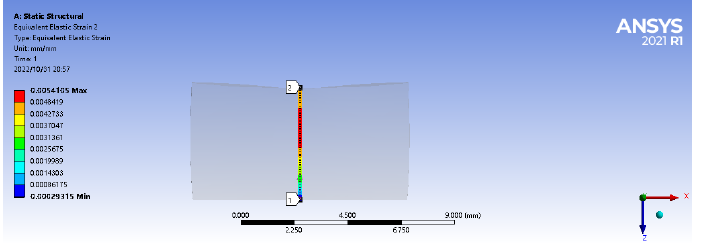
Figure 4. Vertical path diagram.